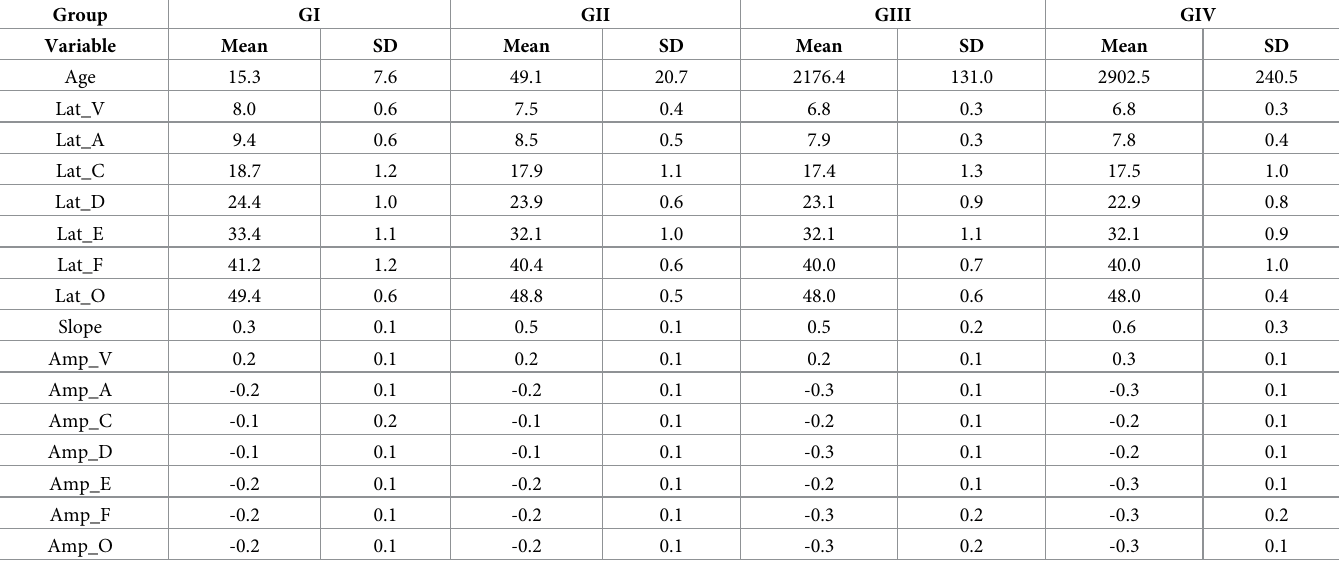
Table 2. Descriptive values of the Frequency-Following Response variables for groups I, II, III and IV. Group GI